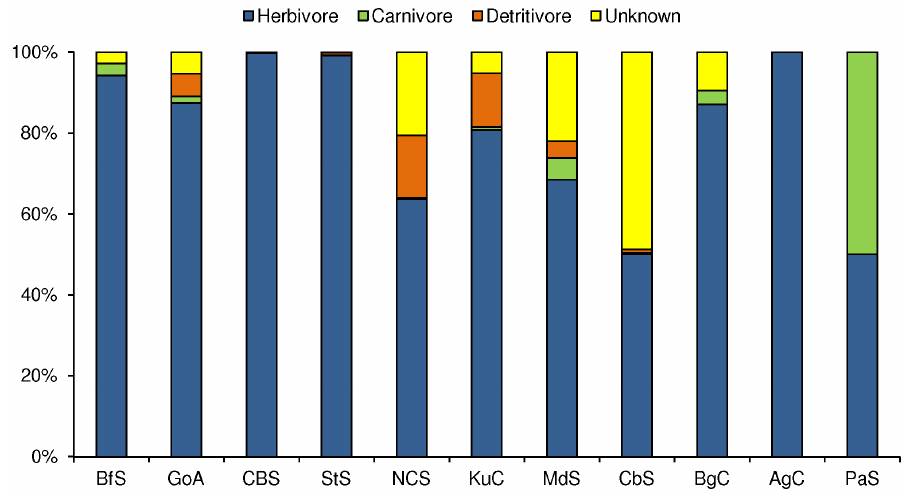
Figure 2. Proportional abundance of gastropod functional feeding groups per LME. LME abbreviations as in figure 1. doi:10.1371/journal.pone.0071396.g002 10 u N (Cayo Mero) and 34 u S (Oyster Bay) (Figure 3B). At these latitudes, most of the high densities observed resulted from a few species within one or two genera, and all of the family Littorinidae with the exception of the Caribbean sites at 10 u N, in which the most abundant species were Angiola lineata (Family Planaxidae) and Sinezona confusa (Family Scissurellidae). Within the Littorinidae, two species of the genus Afrolittorina were found with an average density of 4864 6 480 ind/m 2 in the Agulhas Current (Oyster Bay, 34 u S), while on the Scotian Shelf (Canso, 45 u N), the genus Littorina was the most abundant with an average density of 5955 6 485 ind/m 2 , and in the Gulf of Alaska, the genus Lacuna was the most abundant with an average density of 3706 6 163 ind/m 2 . Individuals of the littorinid family accounted for 99% of all abundance in the Agulhas Current and Scotian Shelf LMEs and for nearly 60% of all abundance in the Gulf of Alaska. When examining standard-